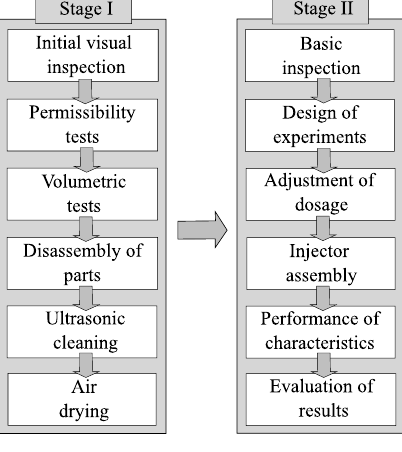
Fig. 2. Denso injector research methodology